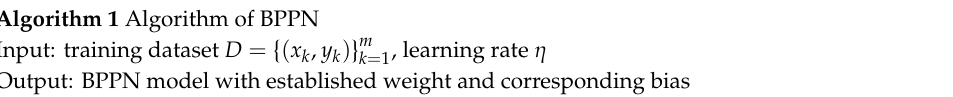
Algorithm 1 Algorithm of